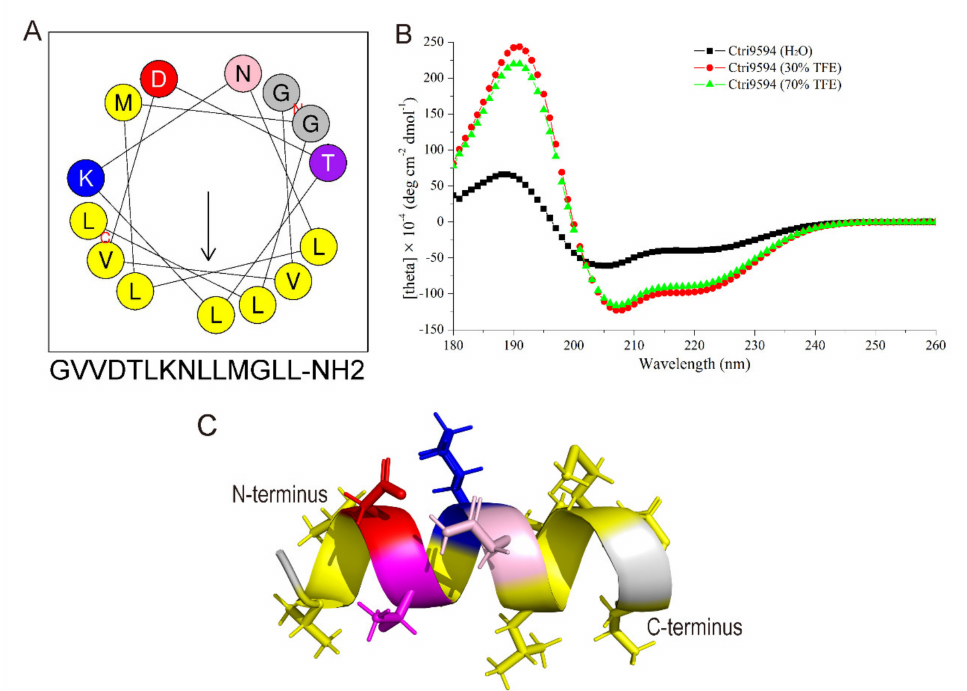
Figure 5. Structure analysis of Ctri9594 peptide. ( A ) Helical wheel diagram of the peptide Ctri9594 determined by the Heliquest method. The representation of the peptide Ctri9594 as a helical wheel shows the hydrophilic face and hydrophobic face. ( B ) CD spectra of the peptide Ctri9594 (100 mg/mL) in H 2 O alone or with 30 or 70% aqueous TFE. ( C ) Molecular modeling of three-dimensional structure of the peptide Ctri9594. Amino acid residues Leu (L), Val (V) and Met (M) are in yellow. Amino acid residue Asp (D) is in red. Amino acid residue Lys (K) is in blue. Amino acid residue Thr (T) is in purple. Amino acid residue Asn (N) is in pink. Amino acid residue Gly (G) is in